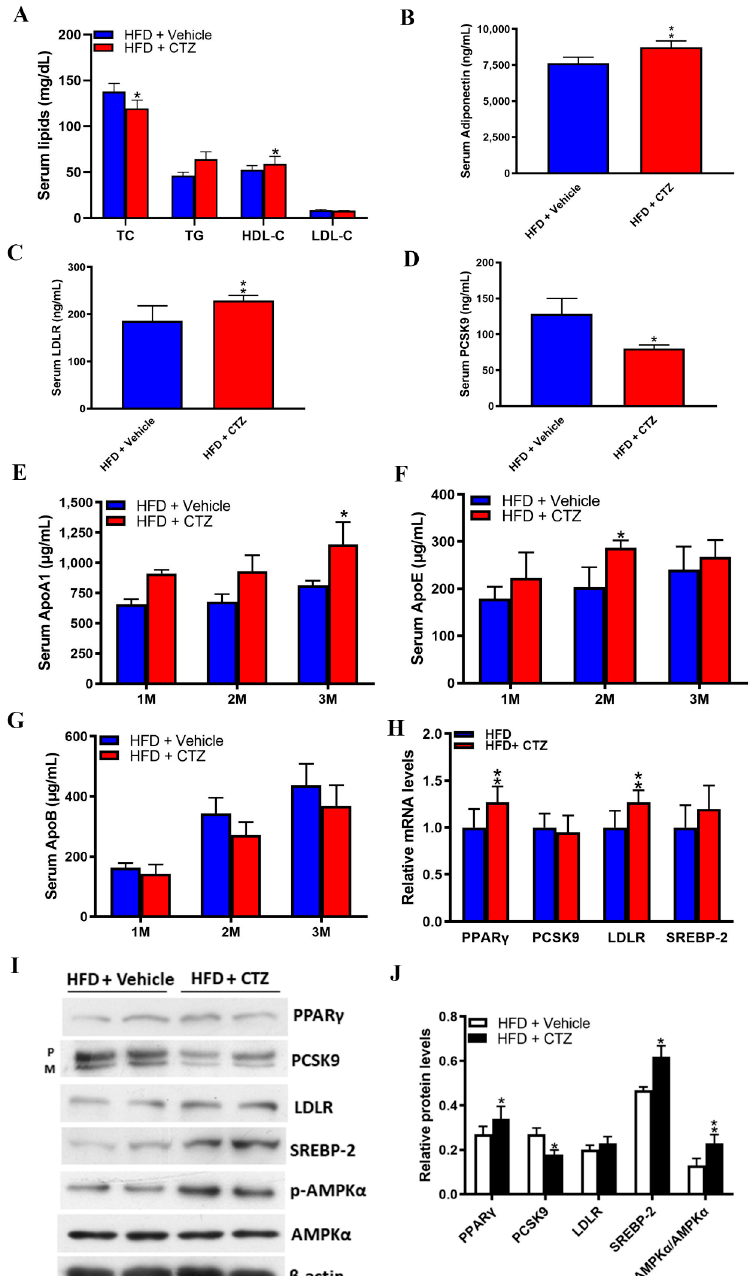
Figure 6. Effects of cilostazol on lipid homeostasis-relevant profile in the serum or liver of the mice fed with HFD. ( A – D ) Quantification of serum levels of lipid profile, adiponectin, PCSK9, and LDLR in HFD-fed mice treated with cilostazol or vehicle. * p < 0.05 versus vehicle-treated group. ** p < 0.01 versus vehicle-treated group. ( E – G ) Quantification of serum levels of ApoA1, ApoB, and ApoE in HFD-fed mice treated with cilostazol (red bar) or vehicle (blue bar). * p < 0.05 versus vehicle-treated group. ** p < 0.01 versus vehicle-treated group. Mouse serum Apo A1, Apo B, and Apo E levels were detected using ELISA kit. ( H ) Quantification of relative mRNA expression in the cilostazol-treated and vehicle-treated groups. ** p < 0.01 versus the vehicle-treated group. ( I ) Protein expression of PPAR γ , PCSK9, LDLR, SREBP-2, and phosphorylated AMPK α were measured by Western blotting in the liver of the mice fed with HFD. β -actin was used as a loading control. ( J ) Quantification of blot intensity relative to loading control is shown. * p < 0.05 and ** p < 0.01 versus the vehicle-treated